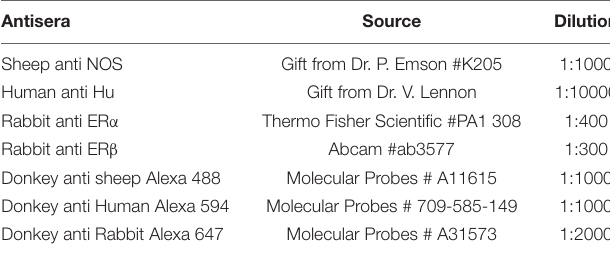
TABLE 1 | Antisera used for evaluation of NOS neurons and estrogen receptor alpha (ER α ) in whole mount preparations of myenteric plexus. Antisera Source Dilution Sheep anti NOS Gift from Dr. P. Emson